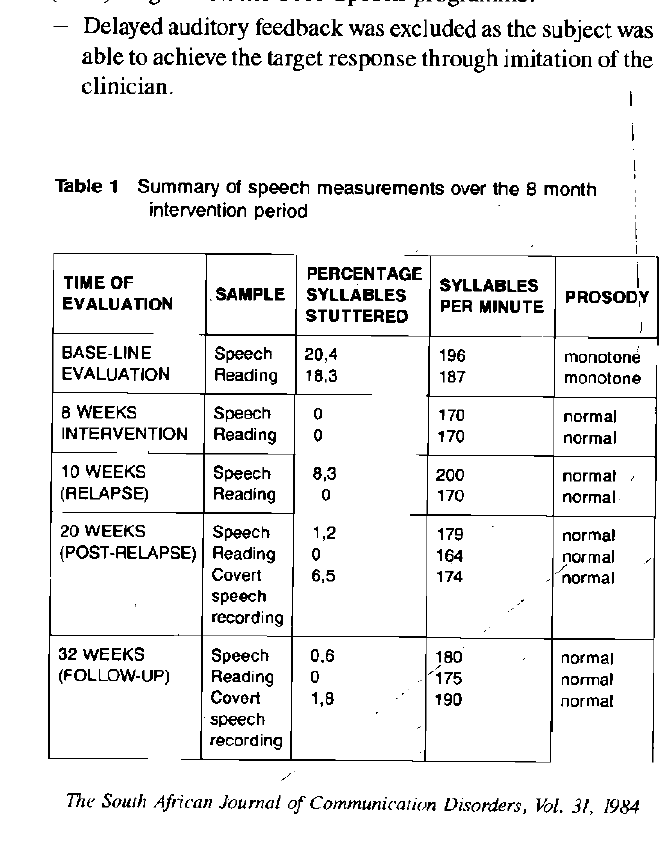
Table 1 Summary of speech measurements over the 8 month intervention